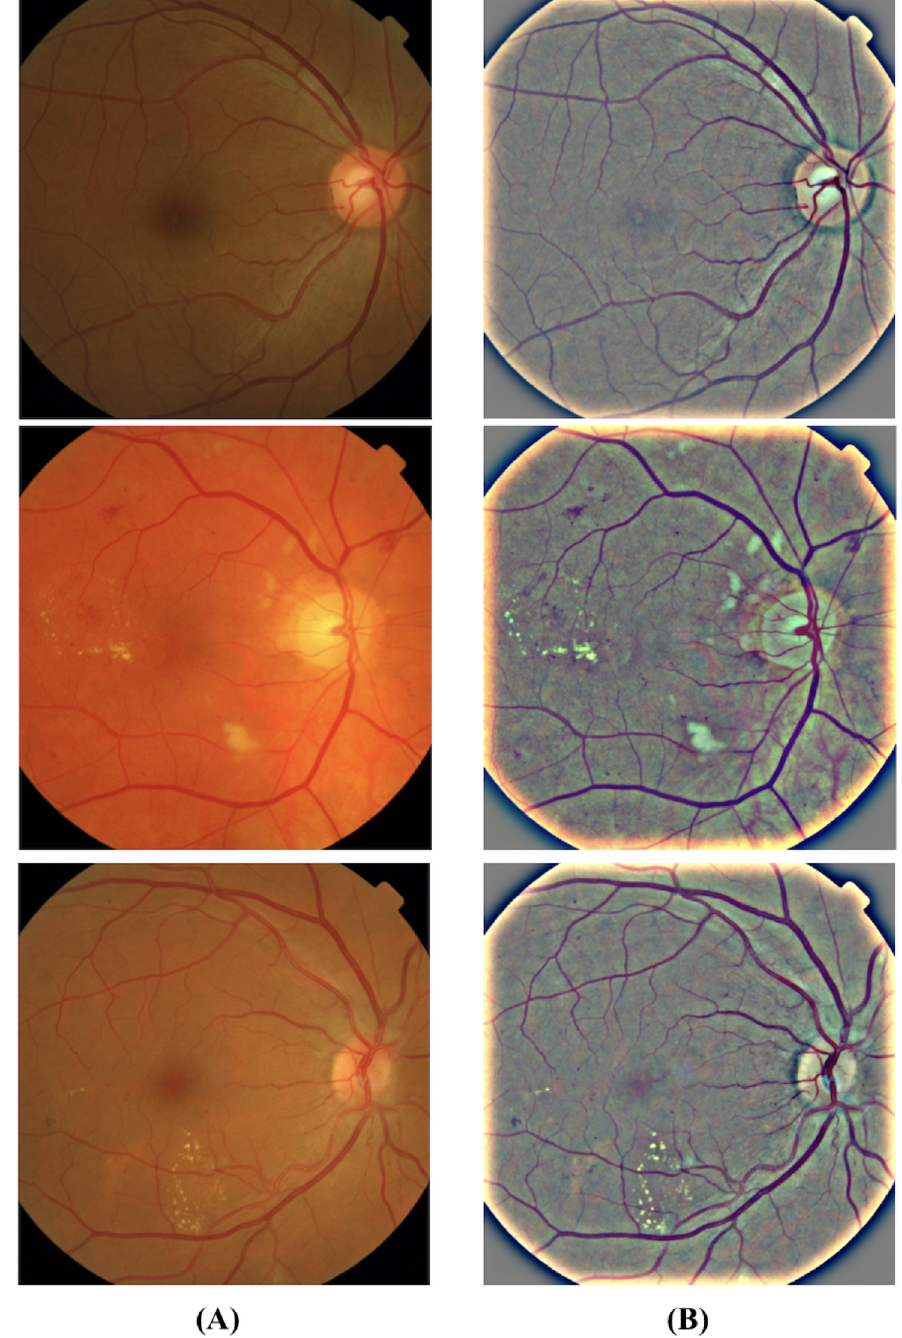
Fig 3. Representative fundus images showing a clear distinction between original and preprocessed images. The images in the column (A) are the raw fundus images and the images in the column (B) show the preprocessed images wherein we can observe the exudates (white/pale yellow spots) and blood vessels more clearly with the controlled background noise.